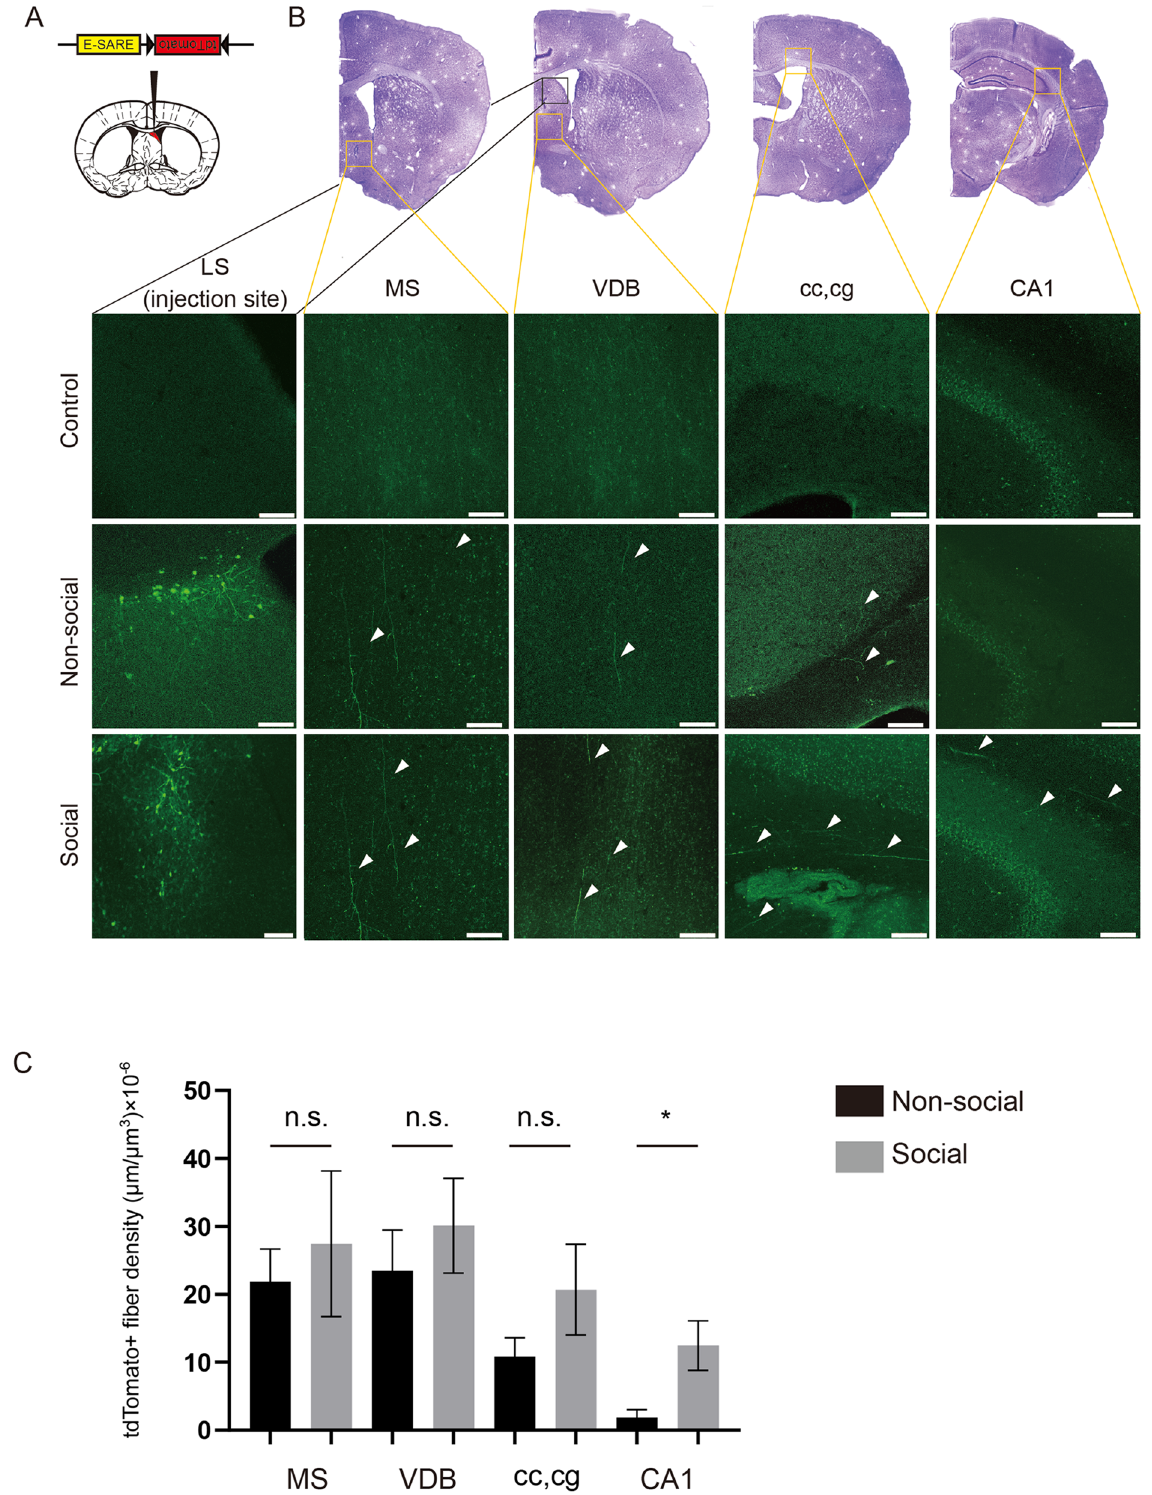
Figure 3. Oxytocin receptor (OXTR)-expressing neurons in the lateral septum (LS), which were activated by social stimulation, projected to the CA1 region of the hippocampus. ( A ) AAV vector constructs expressing E-SARE-FLEX-tdTomato (left) and a stereotaxic map displaying the location of vector expression (right). Brain illustration is an adaption as well as Fig. 1C. ( B ) Projection site of the OXTR+ neurons in the LS that were activated by social or non-social stimulation. ( C ) Quantitative analysis of the density of social stimuli-activated axon projection was performed as indicated in the “Methods”. Scale bars indicate 100 µm. (Control, no viral infection and stimulation; MS medial septum, VDB nucleus of the vertical limb of the diagonal band, cc corpus callosum, cg cingulum) AAV-E-SARE-FLEX-tdTomato was used for the green color in pseudo coloring. N = 3 (Social), N = 6